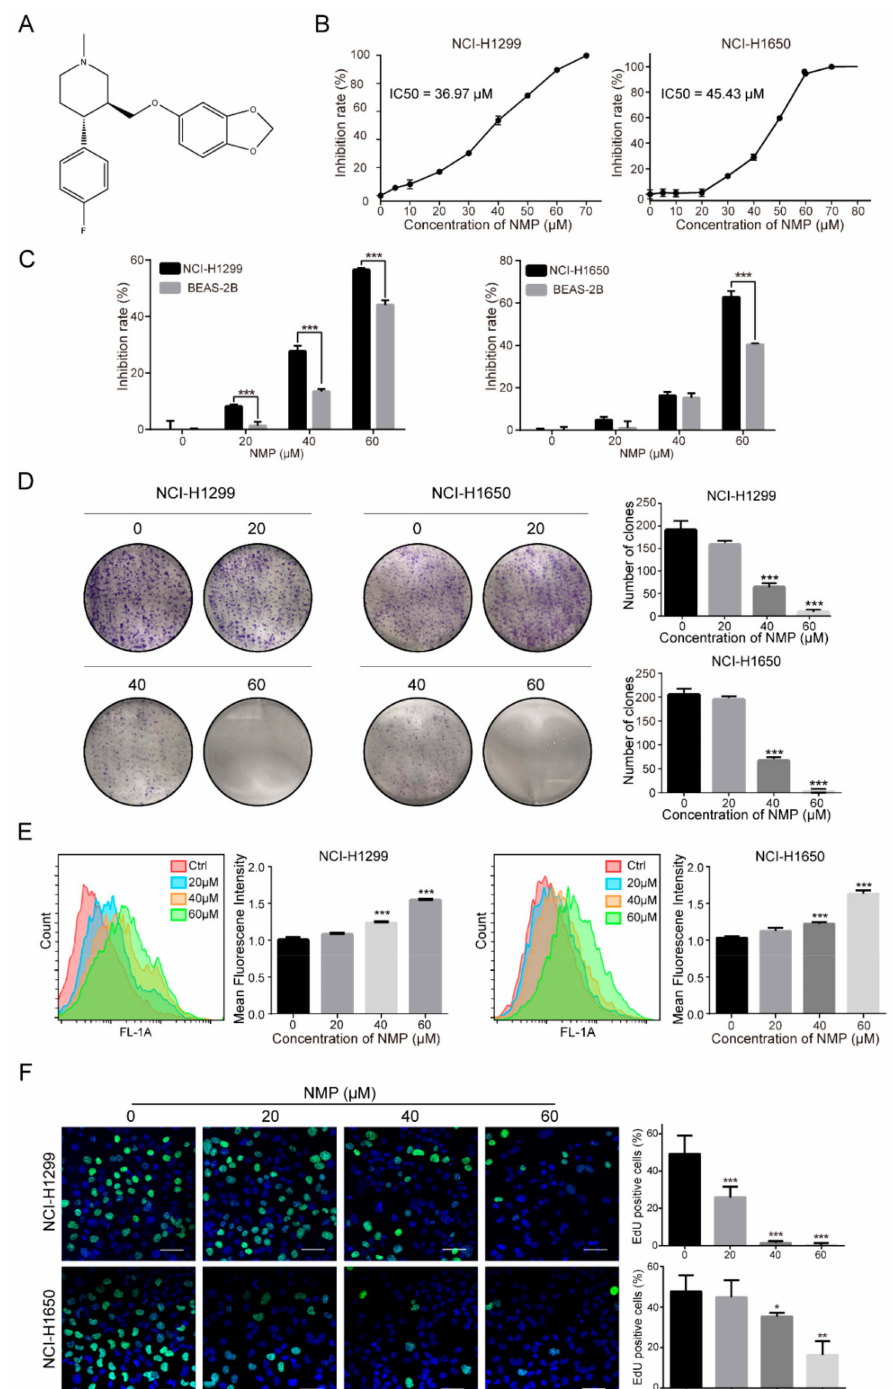
Figure 1. NMP inhibited human NSCLC cell proliferation. ( A ) Molecular structure of NMP. ( B ) Inhibition rates of proliferation in NMP-treated NCI-H1299 and NCI-H1650 cells (24 h) quantified by CCK-8 viability assay. Median inhibitory concentrations (IC50) were estimated by log(inhibitor) vs. normalized response of non-linear regression analysis. ( C ) Inhibition rates of proliferation in NMP-treated NCI-H1299, NCI-H1650 and BEAS-2B cells (24 h) quantified by CCK-8 viability assay. ( D ) Colony formation assay of NCI-H1299 and NCI-H1650 cells, treated with serial concentrations of NMP for 7 days. ( E ) Flow cytometry analyses of 24 h NMP (0–60 µ M) treatment of CFDA-SE-labelled NCI-H1299 and NCI-H1650 cells ( F ) Fluorescence micrographs of NMP (0–60 µ M, 24 h)-treated NCI-H1299 and NCI-H1650 cells with EdU incorporation. Green , EdU-positive cells; blue , Hoechst 33342 for nuclear staining. Scale bar, 20 µ m. Error bars, means ± S.D. of three independent experiments; * p < 0.05, ** p < 0.01,*** p < 0.001, compared to the control